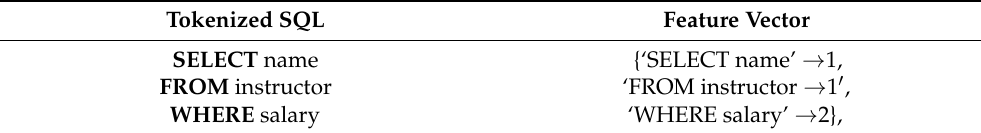
Table 2. An example of a feature